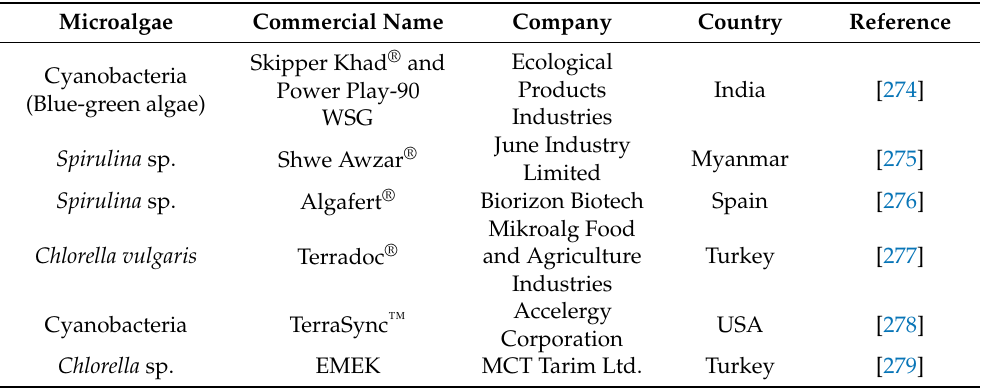
Table 8. Commercialised microalgae-derived